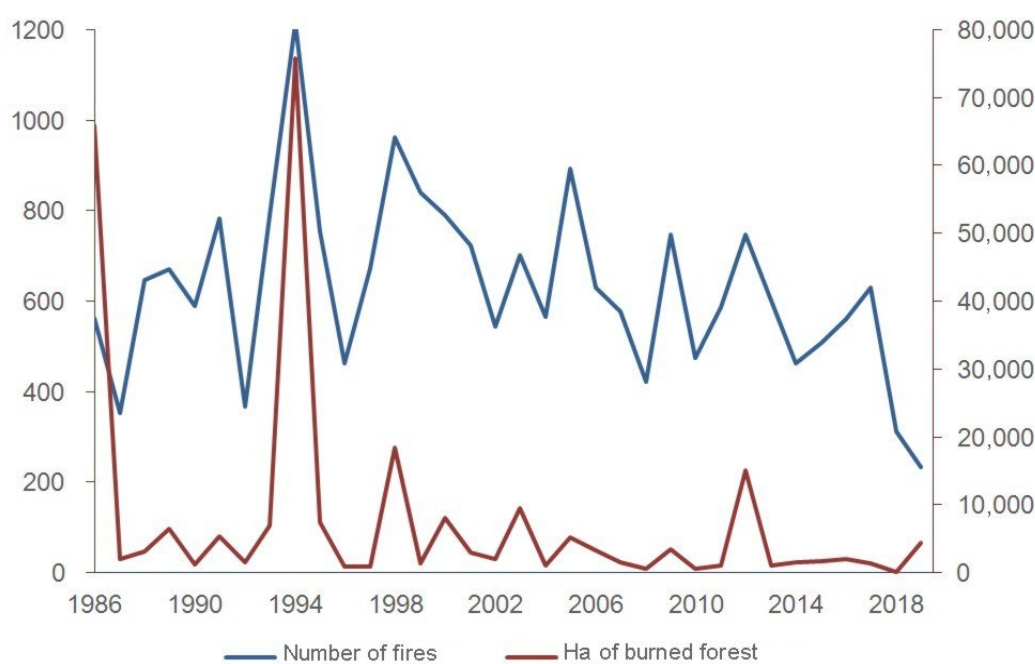
Figure 2. Evolution of forest fires in Catalonia (1986–2019). Source: Government of Catalonia. Department of Agriculture, Livestock, Fisheries, and Food. Directorate-General of Forest Ecosystems and Environmental Management. Forest Fire Prevention Service.